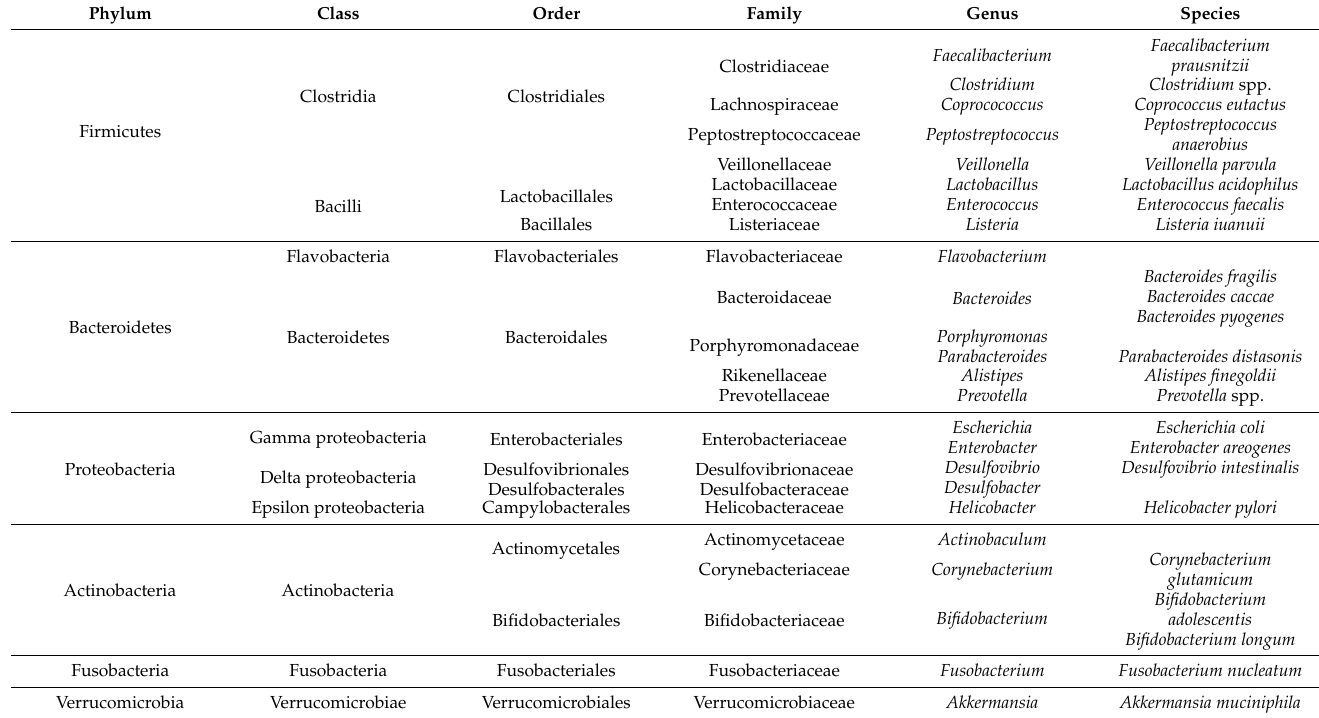
Table 1. Classification of bacterial species in the intestinal flora: According to classification by natural properties, intestinal bacteria can be divided into six categories for the most part: Firmicutes, Bacteroidetes, Proteobacteria, Actinobacteria, Fusobacteria, and Verrucomicrobia. Each category includes bacterial